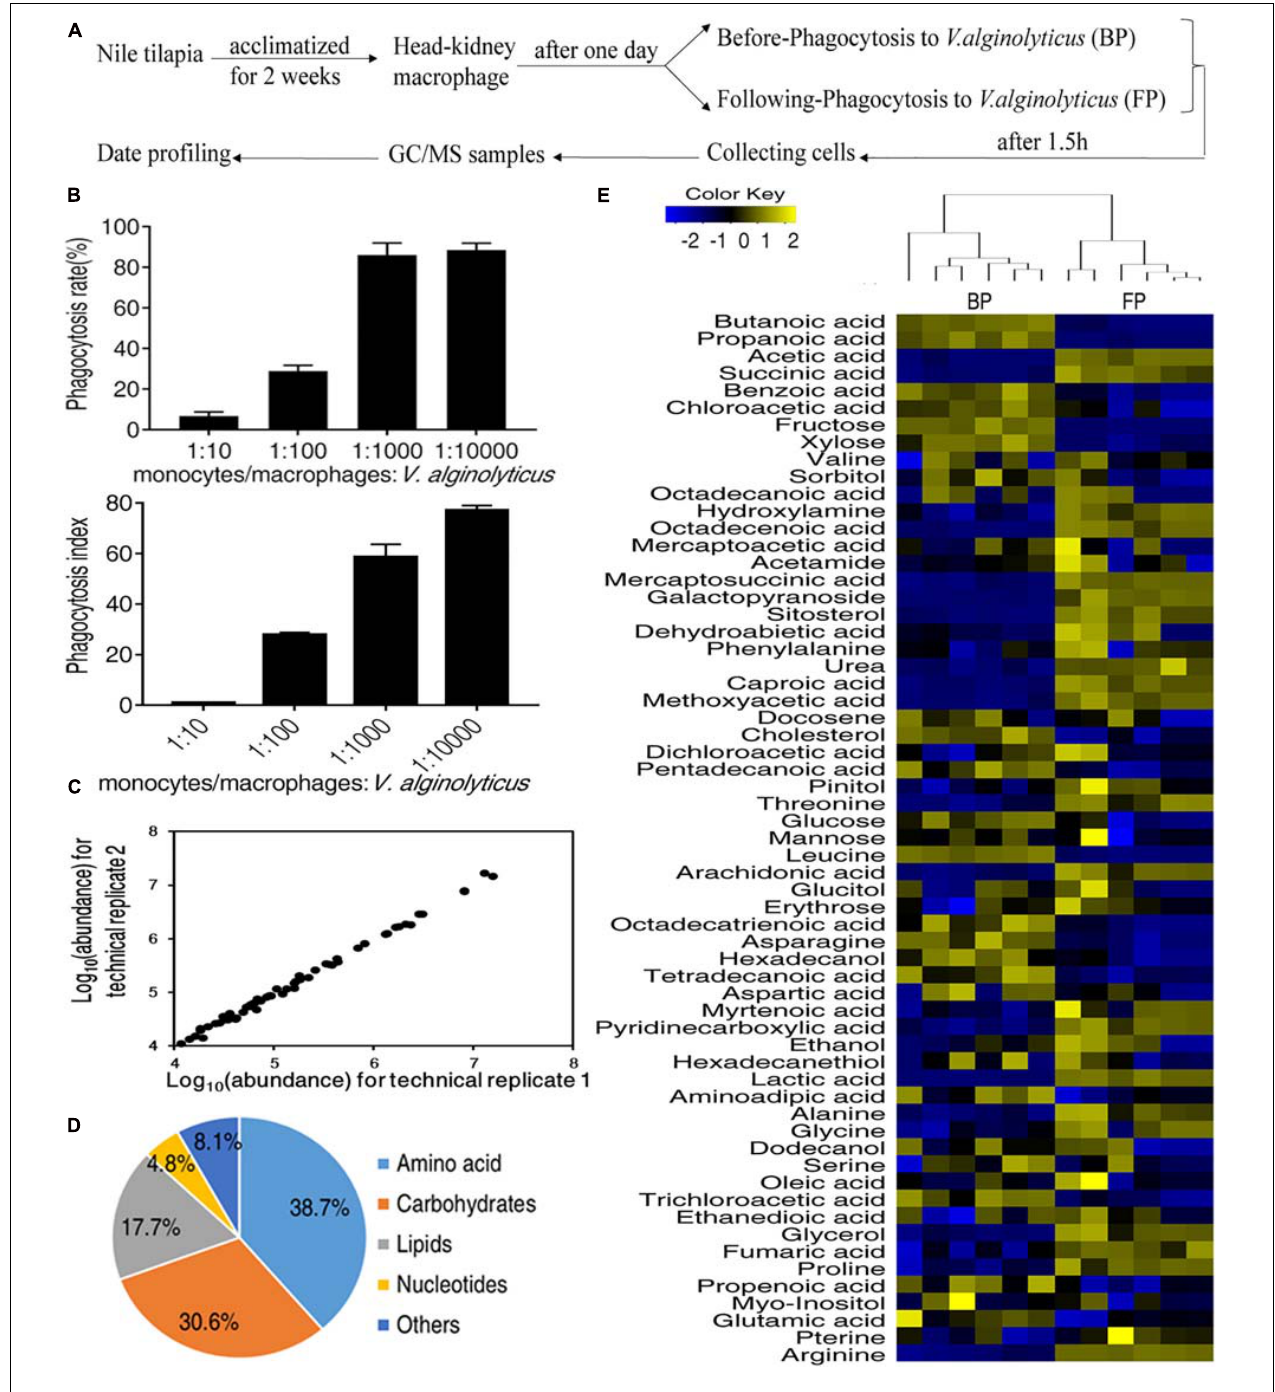
FIGURE 1 | Metabolic profiles of monocytes/macrophages before and following phagocytosis. (A) Schematic representation of experiment workflow; (B) The phagocytosis rate and phagocytic index of monocytes/macrophages. (C) Reliability of metabolomic profiling for the replicates. Pearson correlation coefficient was shown. (D) Functional categories of the metabolites. (E) Heat map of all metabolites (row). Yellow indicates the increase in the abundance of metabolites and blue indicates decrease.